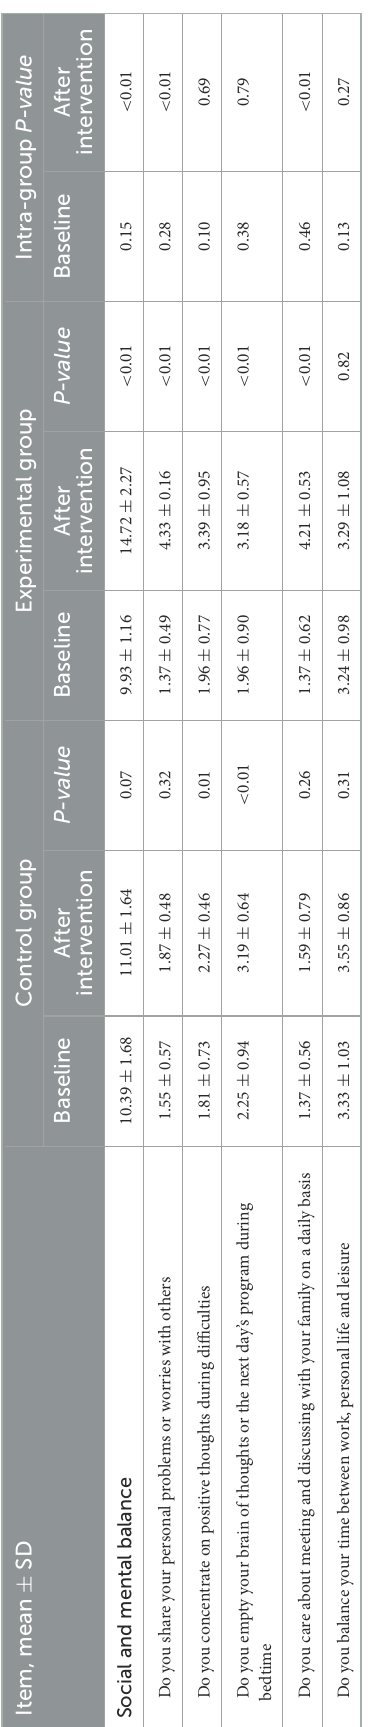
Table 3 presents the comparison of healthy behavior of patients with functional constipation in the experimental and control groups. As shown in the Table 3, the scores before and after the intervention for the same patient were compared. Besides, intra-group comparisons were performed, that is, between control and experimental groups at baseline and between control and experimental groups after intervention. No difference was observed in the baseline health behavior between the two groups ( P > 0.05). The overall average in the experimental group (77.90 ± 14.57) was significantly greater than that in the control group (61.11 ± 13.64) after the intervention ( P < 0.05). The scores in four out of five dimensions, including healthy dietary choices (21.48 ± 3.15 vs. 12.55 ± 2.71), dietary harm avoidance (12.68 ± 2.94 vs. 8.53 ± 1.50), daily routine (23.37 ± 4.72 vs.